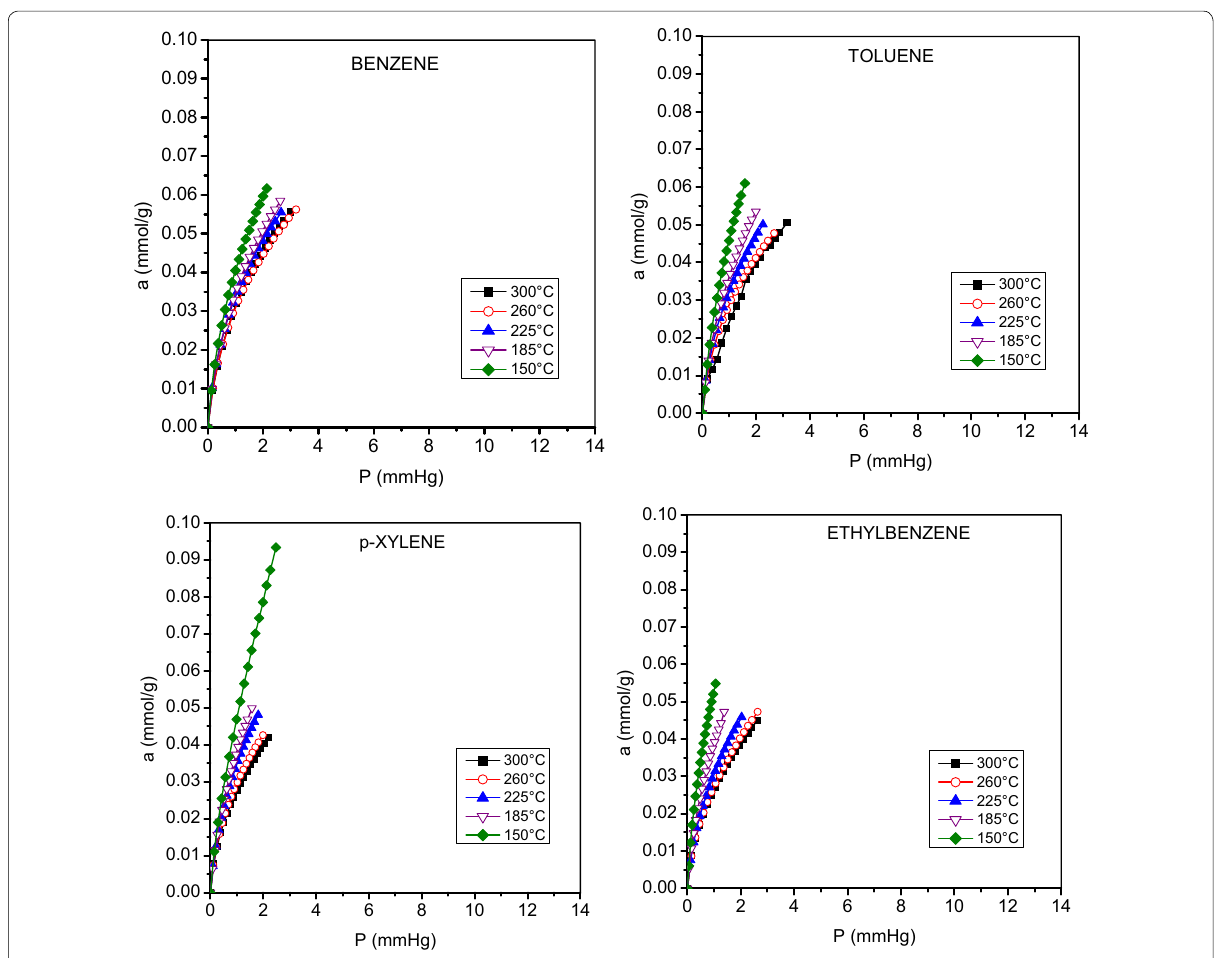
Fig. 5 Benzene, toluene, p ‑xylene, and ethylbenzene adsorption isotherms for SBA‑15/HT